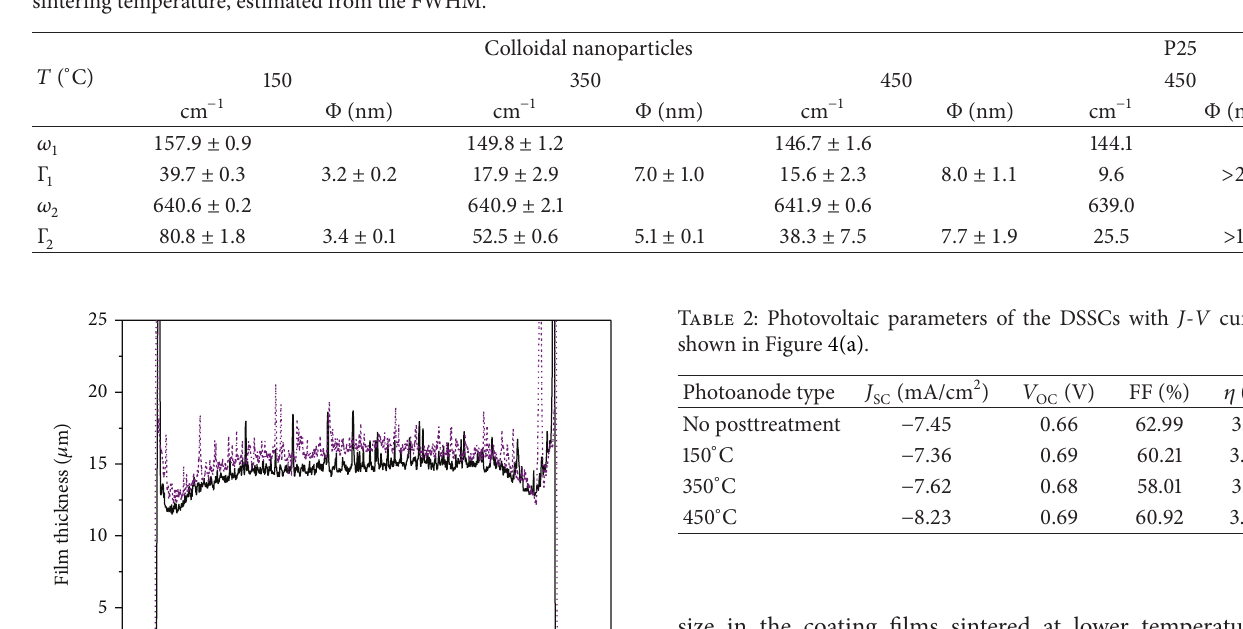
Table 1: Raman shift- 𝜔 and FWHM- Γ of the of the Eg modes around 145cm − 1 and 640cm − 1 nanocrystalline size ( Φ ) dependence on the sintering temperature, estimated from the FWHM.